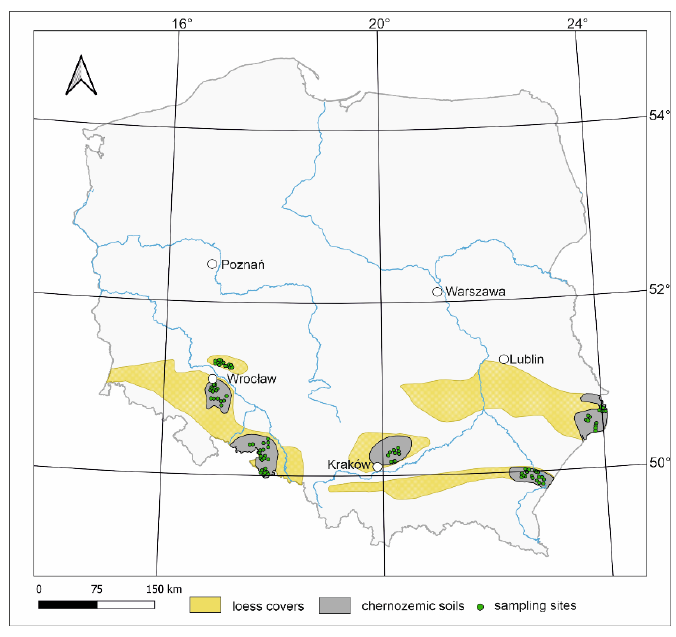
Figure 1. Localization of sampling areas in Southern Poland.